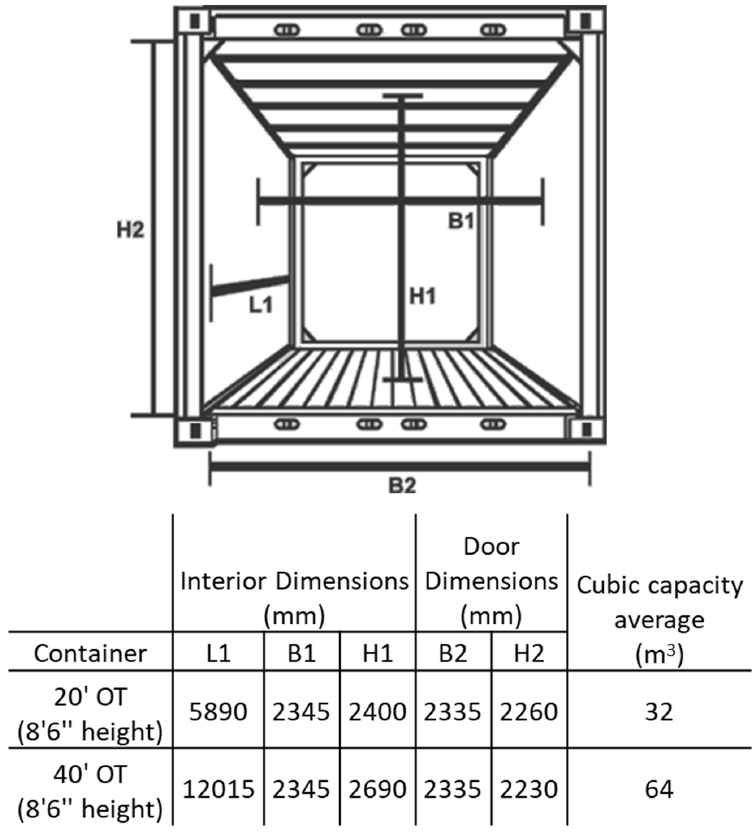
Figure 15. Standard container measurements. Table 2. Properties of the standard containers.